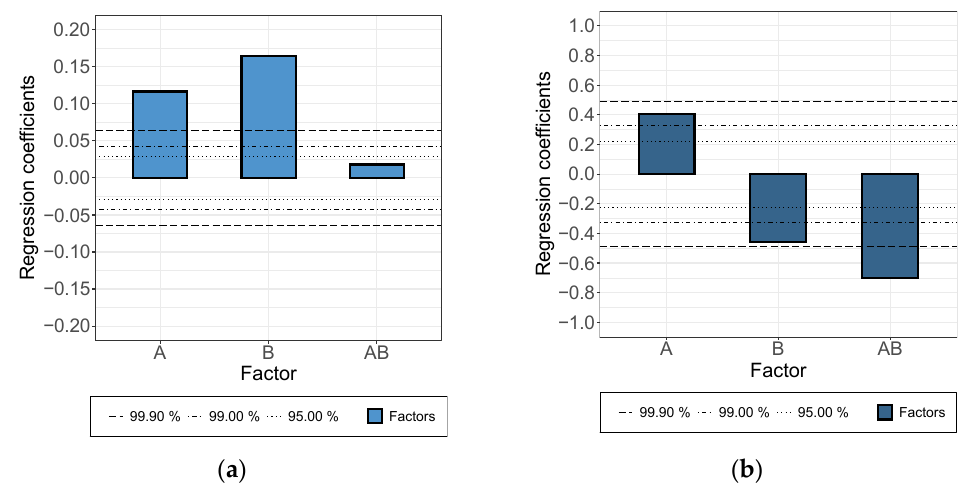
Figure 3. Effects (and confidence intervals) of factors A, B, AB on electrical conductivity of ( a ) the suspension and ( b ) the formed dry layer for rotor ‐ stator dispersing step. A: increasing rotational speed, B: increasing treatment duration, AB: interaction.